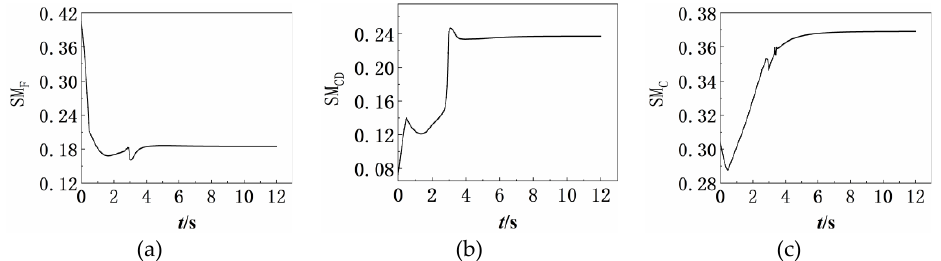
Figure 19. Change curves of the surge margin of working-mode switching from double bypass to single bypass at H = 11 km, Ma = 1.2. ( a ) surge margin of fan; ( b ) surge margin of CDFS; ( c ) surge margin of HPC.